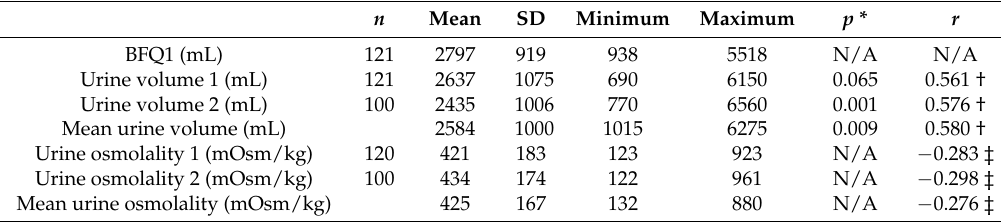
Table 2. Total daily fluid intake as measured by the beverage frequency questionnaire at screening (BFQ1), 24-h urine volume, and 24-h urine osmolality.